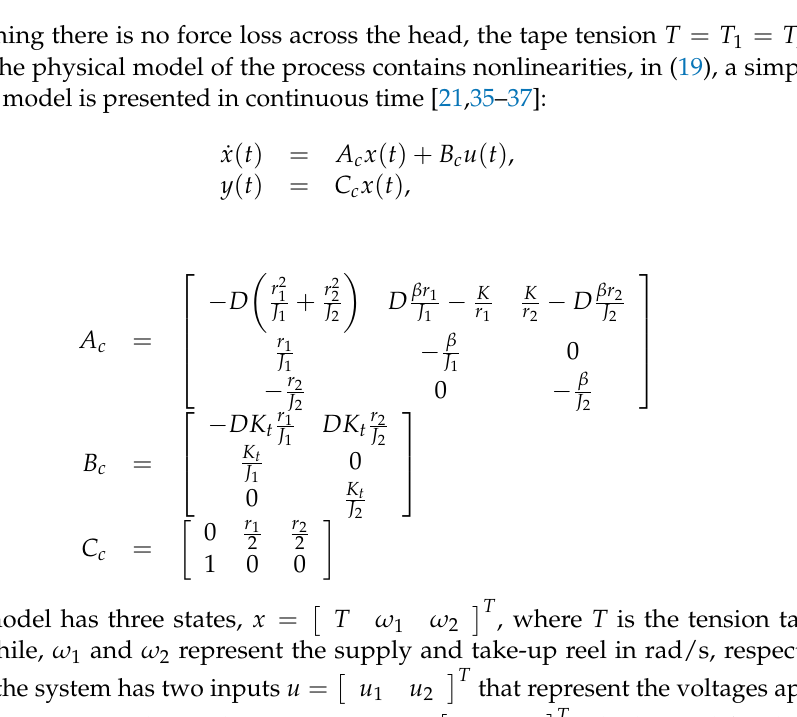
Figure 3. Tape transport system.